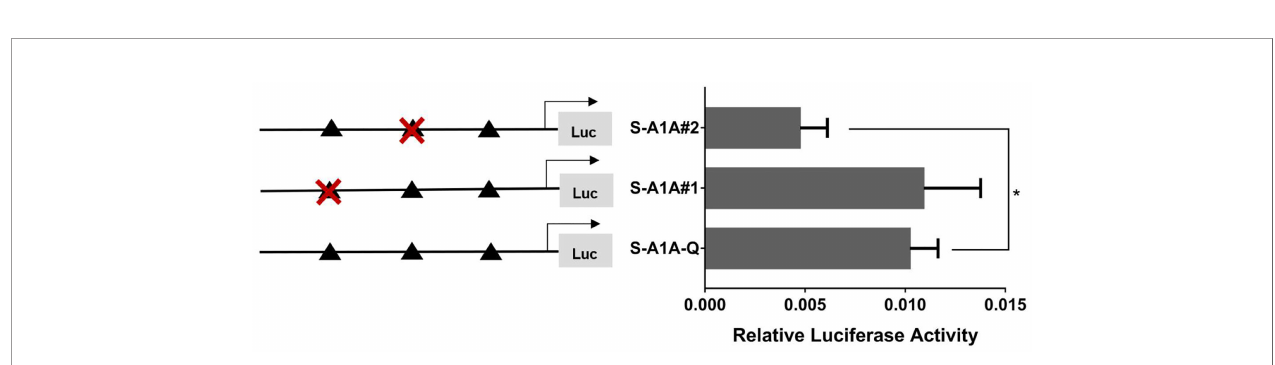
FIGURE 9 | Effect of SF-1 on the transcriptional activity of the cyp19a1a promoter fragment mutated at the transcriptional site. On the left is a schematic diagram of the mutation of the promoter site, and the triangle represents the binding site. The right side is the expression of luciferase in the promoter recombinant vector. The black triangle with a red cross represents the SF-1 mutation site. One-way ANOVA was performed on the data and expressed as mean ± standard deviation (n = 4). *There is a signi fi cant difference between the data.